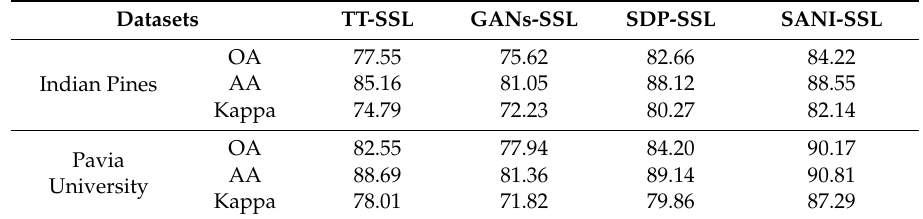
Table 5. Comparison of OAs, AAs, and kappa (as a percentage) between the proposed SANI-SSL method and other spectral-spatial information-based SSL